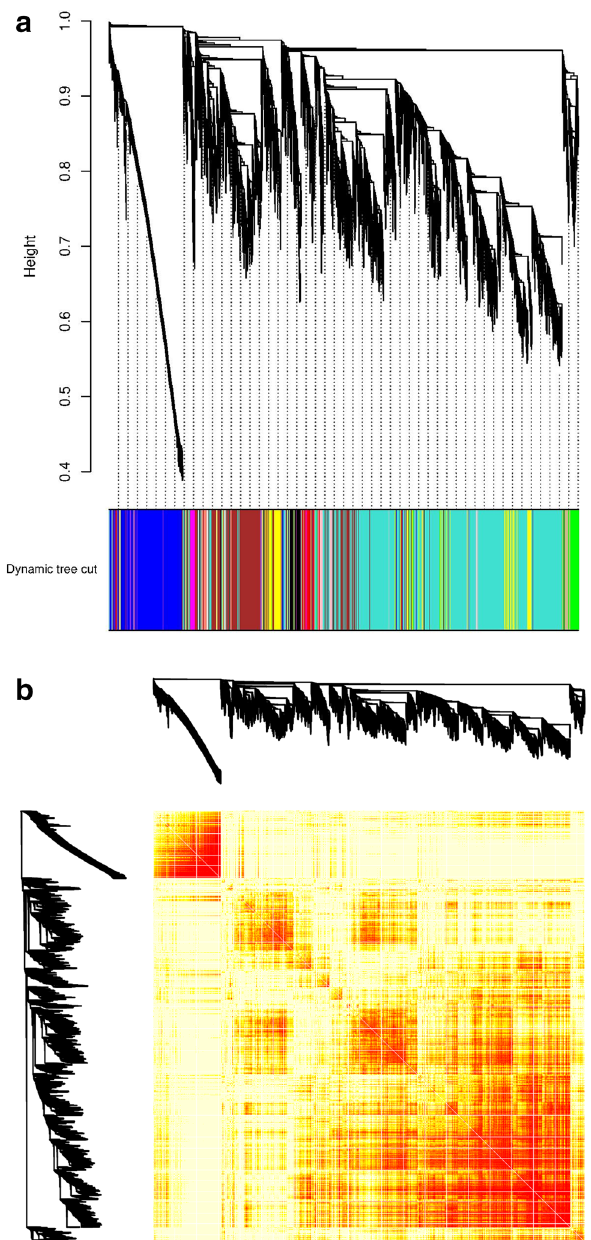
Figure 2. Weighted gene co-expression network analysis (WGCNA) of ( A ) the hierarchical cluster tree of 13,591 meta-genes between the three species. The branches and color bands represent the assigned module; and ( B ) co-expression network modules. In the Topological Overlap Matrix (TOM) plot, the light color represents low overlap and the progressively darker red color represents higher overlap between the